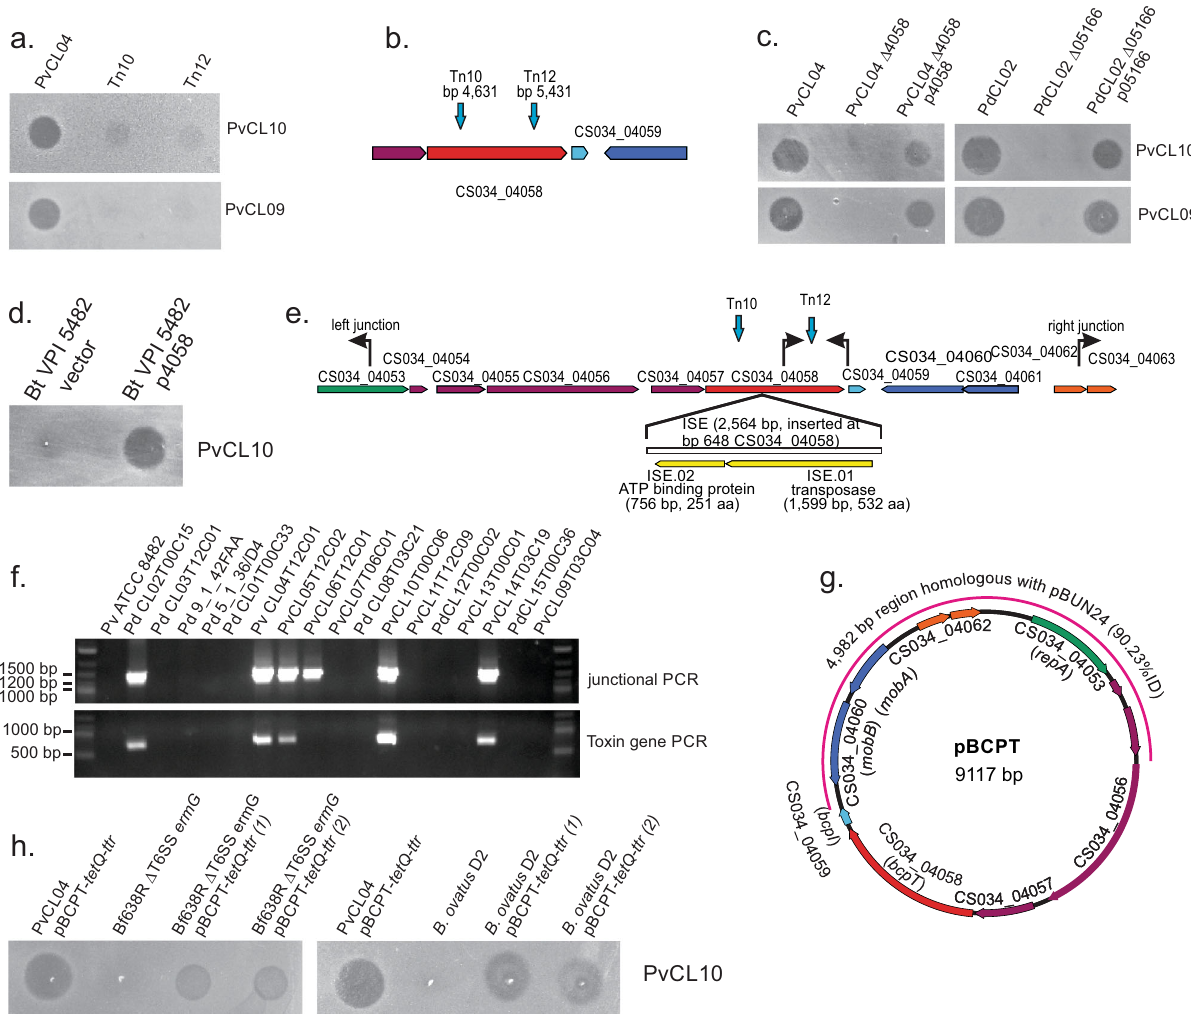
Fig. 2 Identi fi cation of the toxin-encoding gene on a mobile plasmid. a Agar overlay assays of toxin-producing strain PvCL04 and two transposon mutants that abrogate its ability to inhibit the growth of PvCL10 and PvCL09. b Genetic context of the gene into which the two transposons inserted. c Agar overlay assays showing that deletion of the gene identi fi ed by transposon mutagenesis from strains PvCL04 and PdCL02 abrogates toxin activity, which is restored when the gene is added back in trans to these strains. d Agar spot overlay assay showing that placement of CS034_04058 in trans in B. thetaiotaomicron VPI 5482 confers toxin activity to the strain. e Orf map of the contig of the sequenced genome of PvCL04 containing CS034_04058. Primers used to determine if the contig is a circular plasmid and to identify the toxin-producing gene in other strains are shown. Sites of the transposon insertions of mutants Tn10 and Tn12 are shown. An insertion sequence present in a similar contig of strain PvCL10 is shown under the map with its insertion site mapped relative to the contig of PvCL04. f EtBr-stained gel showing the results of the PCR using the primers shown in panel E with each of the 18 P. vulgatus and P. dorei strains listed in Fig. 1a. PCR analyses were performed twice. g The circular 9117 pBCPT plasmid of strain PvCL04 showing the portion of the contig that is similar to the Bacteroidales mobile plasmid pBUN24 (pink outer line). The gene shown in green encodes a plasmid replication protein, the genes in blue encode mobilization proteins, and the genes in orange encode a putative toxin-antitoxin system. h Overlay assays showing that B. fragilis Δ T6SS ermG and B. ovatus D2 that conjugally received pBCPT- tetQ-ttr from PvCL04 pBCPT- tetQ-ttr acquire the ability to inhibit the growth of PvCL10. All overlay assays were performed at least twice. Source data are provided as a Source Data fi